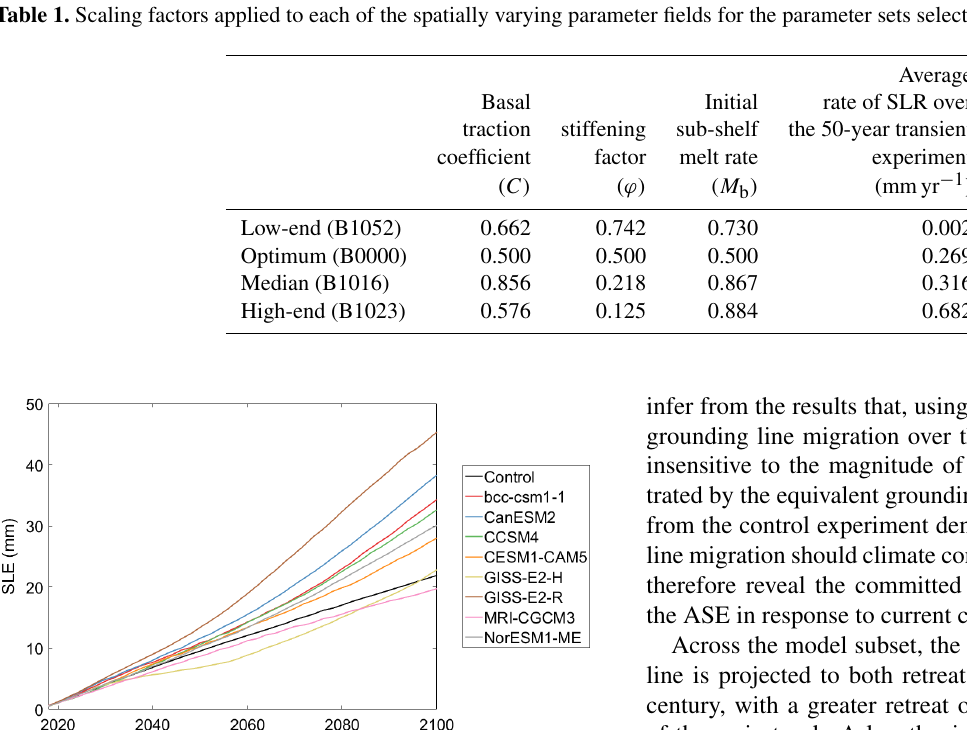
Table 1. Scaling factors applied to each of the spatially varying parameter fields for the parameter sets selected from the N16 ensemble.